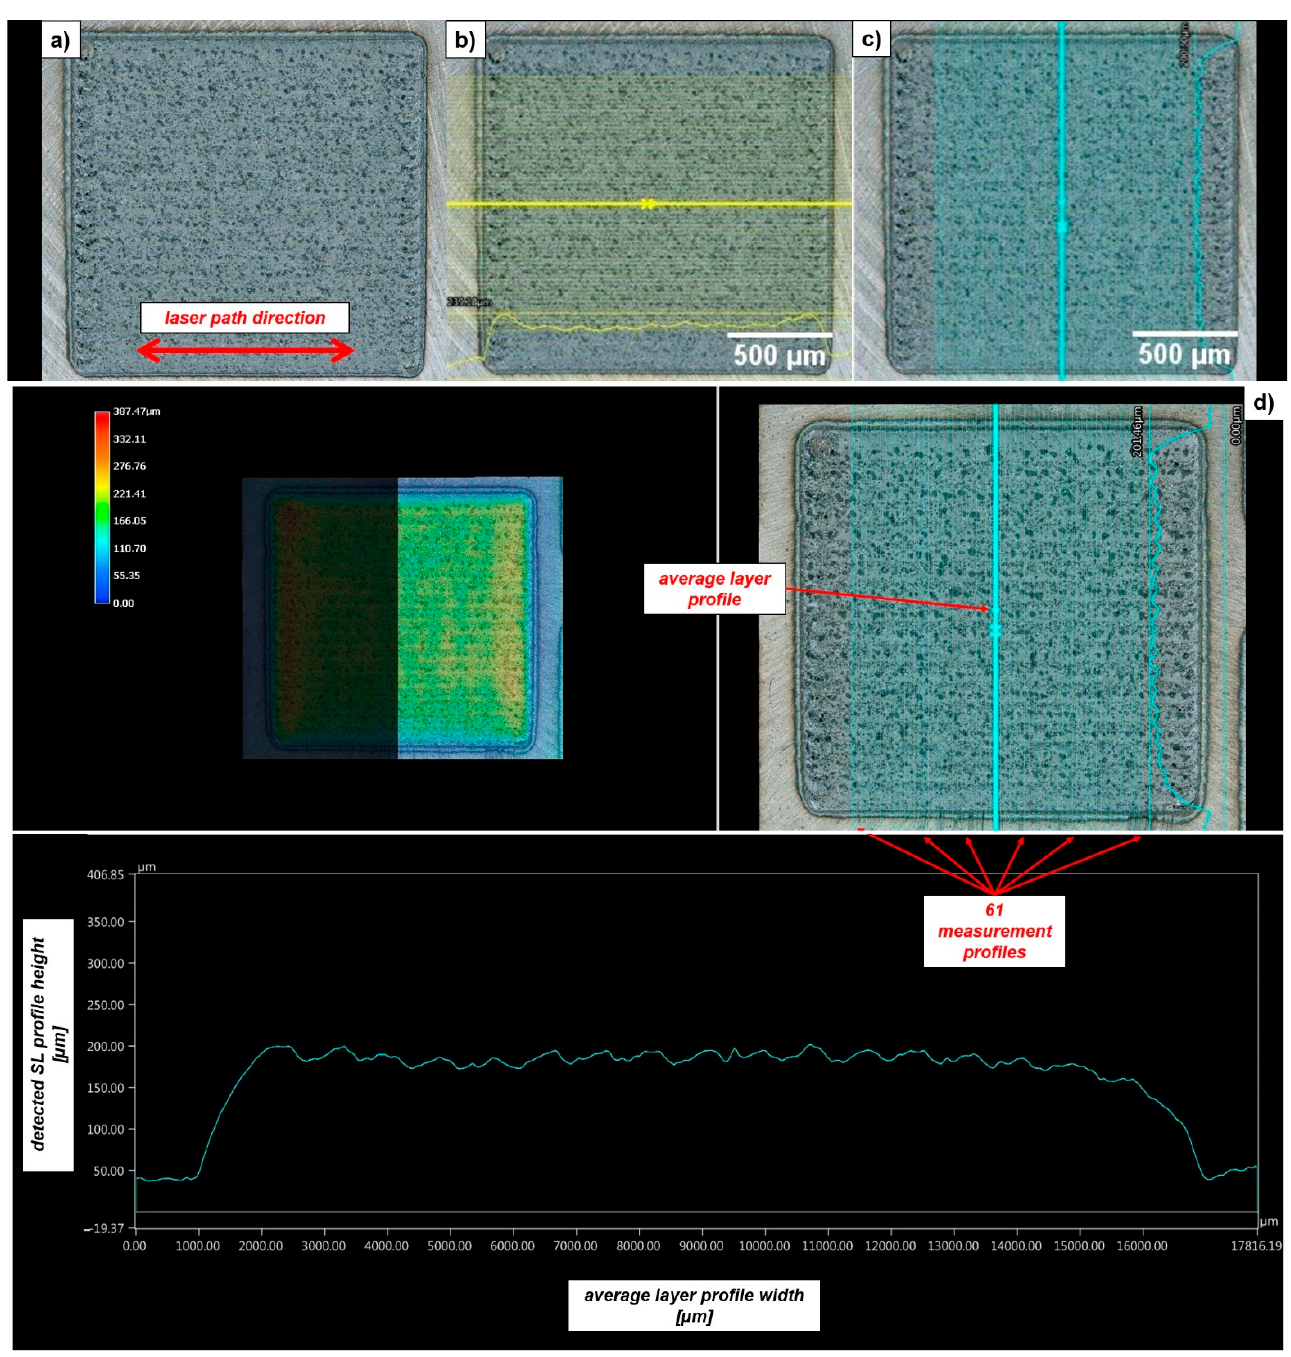
Figure 5. Single Track (ST) acquisition and characterization: ( a ) Inconel 718 ST acquisition; ( b ) tracing of 61 profiles crossing the ST length; ( c ) average ST profile detection.